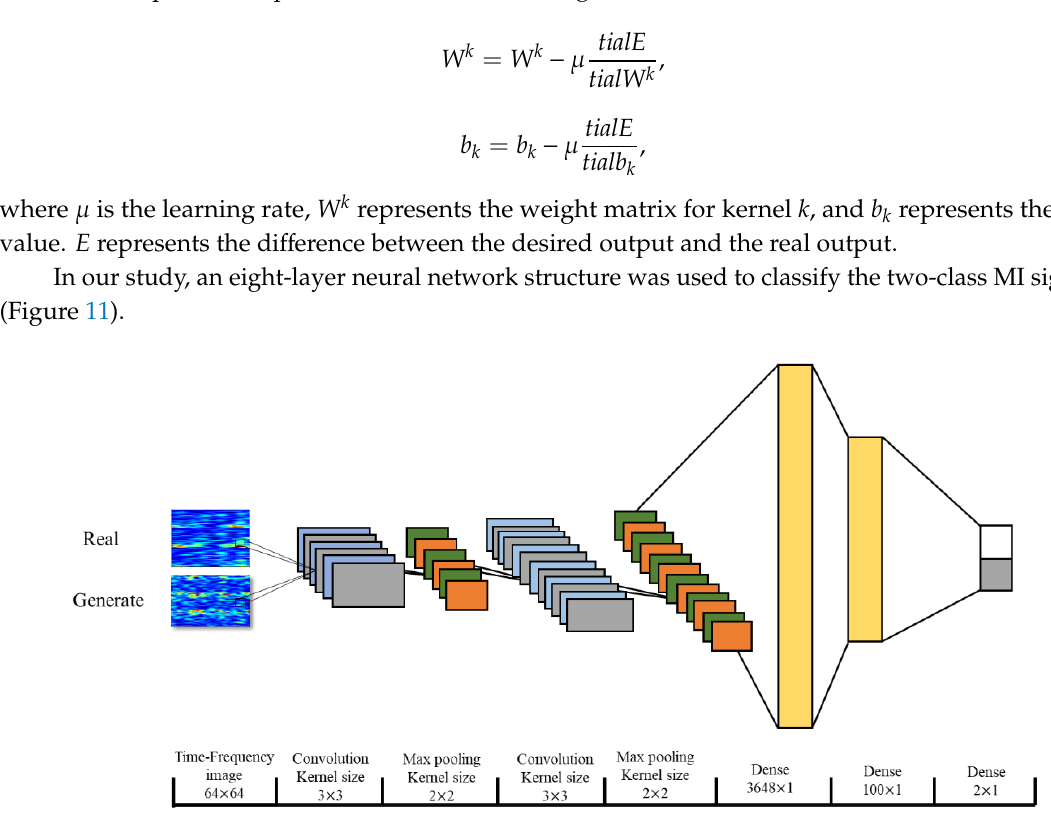
Figure 11. The structure of the convolutional neural network (CNN) model.